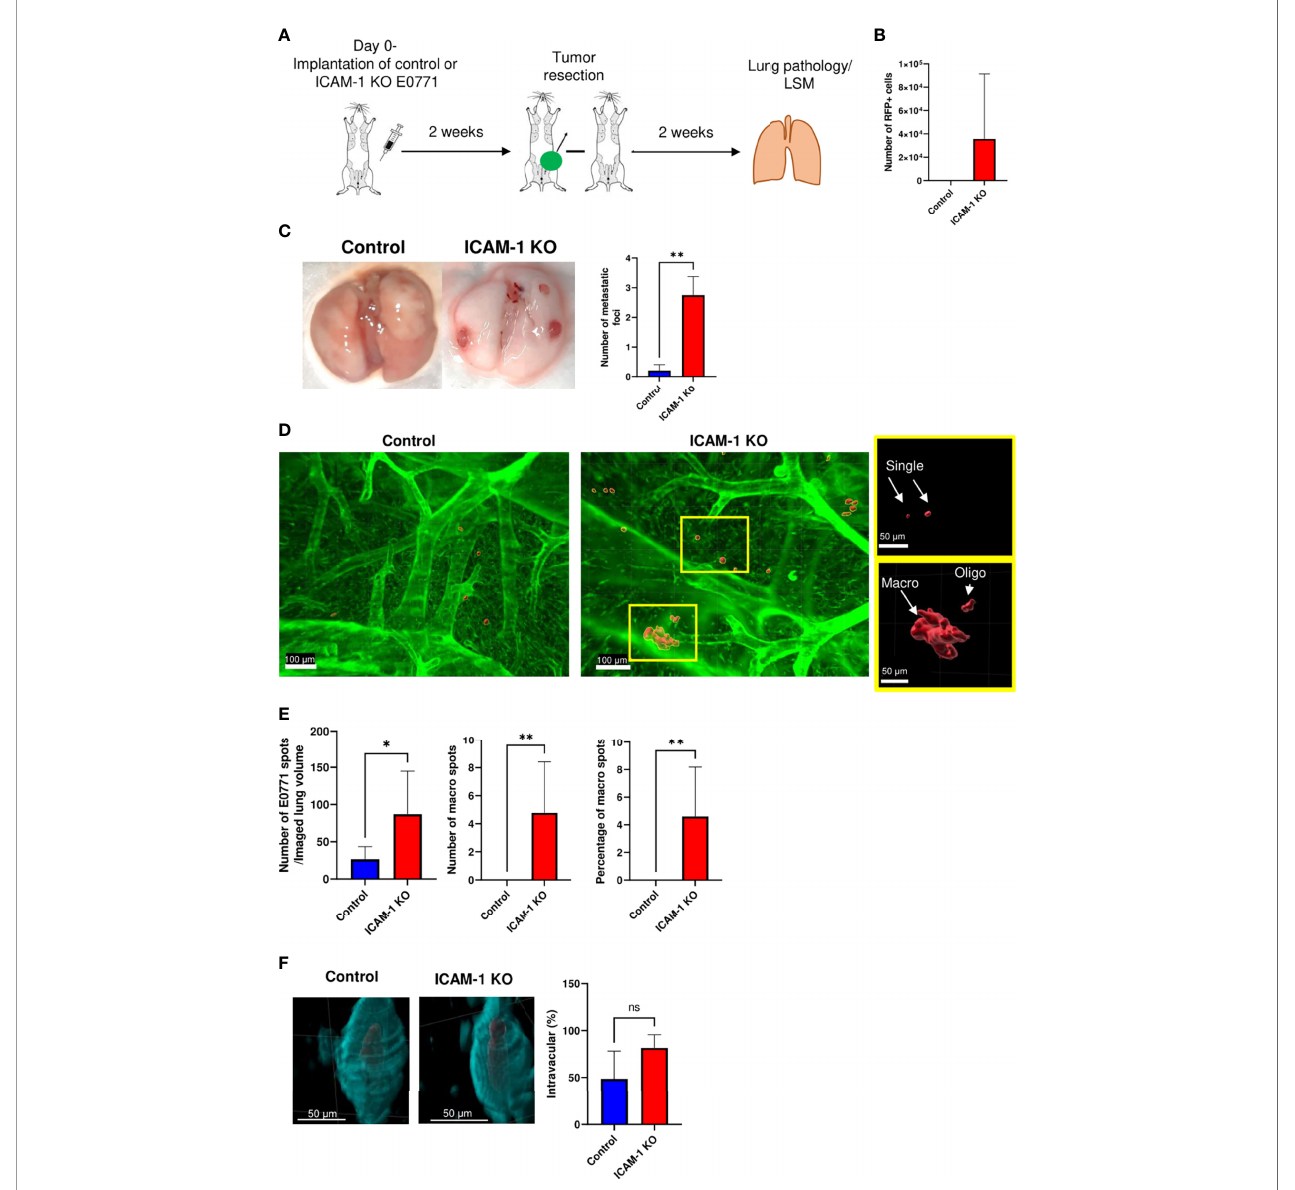
FIGURE 5 | ICAM-1 expression by E0771 breast cancer cells suppresses the late growth of disseminated cancer cells in a spontaneous model of breast cancer metastasis to lung. (A) A scheme depicting the experiment. 3×10 5 control or ICAM-1 KO E0771 cells were implanted in the mammary fat pads of recipient mice. Tumors were resected 2 weeks later, and 2 weeks after resection, the lungs were harvested and processed for either the FACS analysis of total cell suspensions or of lungs subjected to fi xation and clearance for imaging by LSM. The mice were intravenously stained with Alexa fl uor 647-labeled CD31 mAb 15 min before lung harvesting as in Figure 4 . (B) The number of RFP-positive E0771 cells recovered in the lungs determined by FACS. The bars depict the mean values ± SEM n=6. (C) Two weeks after tumor resection, lungs were harvested and the number of tumor foci detected on the lung surface was determined. The left panel depicts representative lung images. The right panel depicts the number of tumor foci on the lung surface ± SEM. n=4. ** p <0.005. (D) Representative LSM images of RFP control and ICAM-1 KO cells disseminated from their respective primary breast tumors and accumulated in the lung lobes. The rectangles in the ICAM-1 KO lung image contain representative single tumor cells (i.e., spots of <3,000 µm 3 , top rectangle) or either oligocellular lesions or macrolesions (>40,000 µm 3 , bottom rectangle). The rectangles are each magni fi ed in the two right images. Green: lung auto- fl uorescence. Red: E0771 cells. (E) The left graph depicts the mean ± SEM number of RFP E0771 spots detected in 8 imaged lung cubes (each 2,160 µm × 2,560 µm × 2,000 µm in dimension). The middle graph depicts the mean ± SEM number of macrolesions detected in 8 lung cubes. The right graph depicts the mean ± SEM percentages of macrolesions out of all E0771 spots detected. * p <0.05; ** p <0.005. (F) The left and right images depict, respectively, control and ICAM-1 KO E0771 cells (red) entrapped inside CD31-labeled lung blood vessels (cyan). The bars in the right panel depict the percentage of control or ICAM-1 KO E0771 cell spots detected inside the CD31-labeled lung vessels. Results are mean ± SEM of the same 8 lung cubes analyzed in